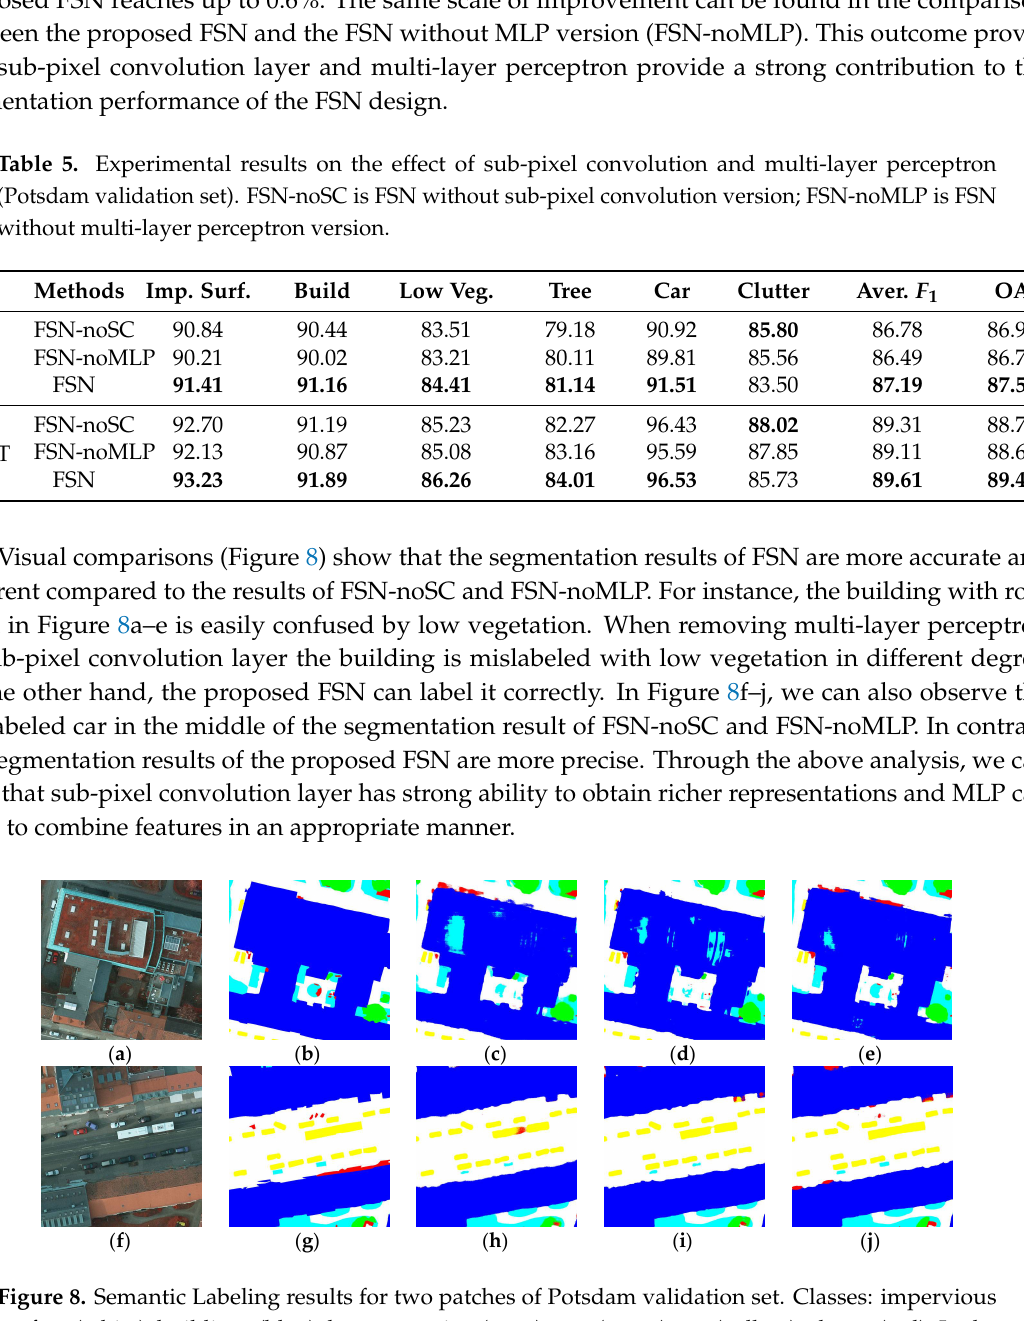
( b ) Figure 9. Errors of commission and omission of each model per classes (Potsdam dataset): ( a ) error of commission; and ( b ) error of omission. Lower values indicate the better segmentation performance. Table 6. Experimental results on Potsdam test set. Methods Imp. Surf. Build Low Veg.